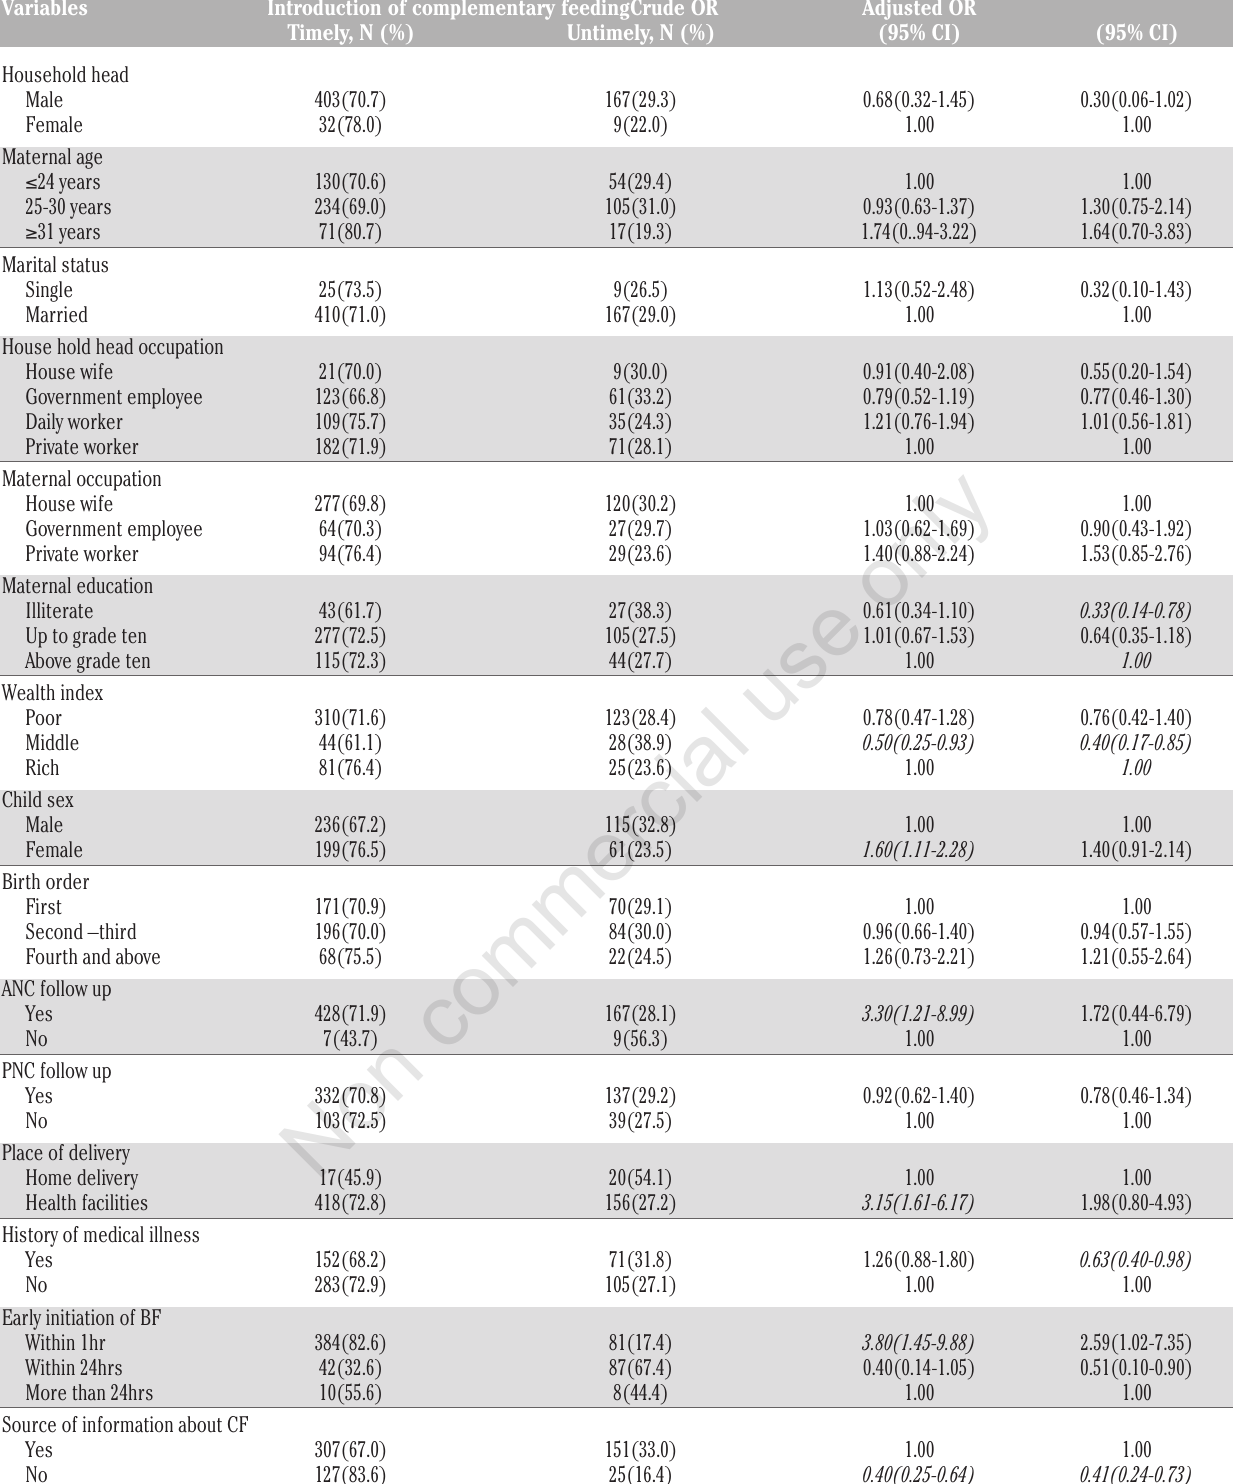
Table 2. Multivariable logistic regression analysis of factors associated with timely introduction of complementary feeding in children 6-23 months of age in Wolaita Sodo town, Ethiopia in 2015. Variables Introduction of complementary feedingCrude